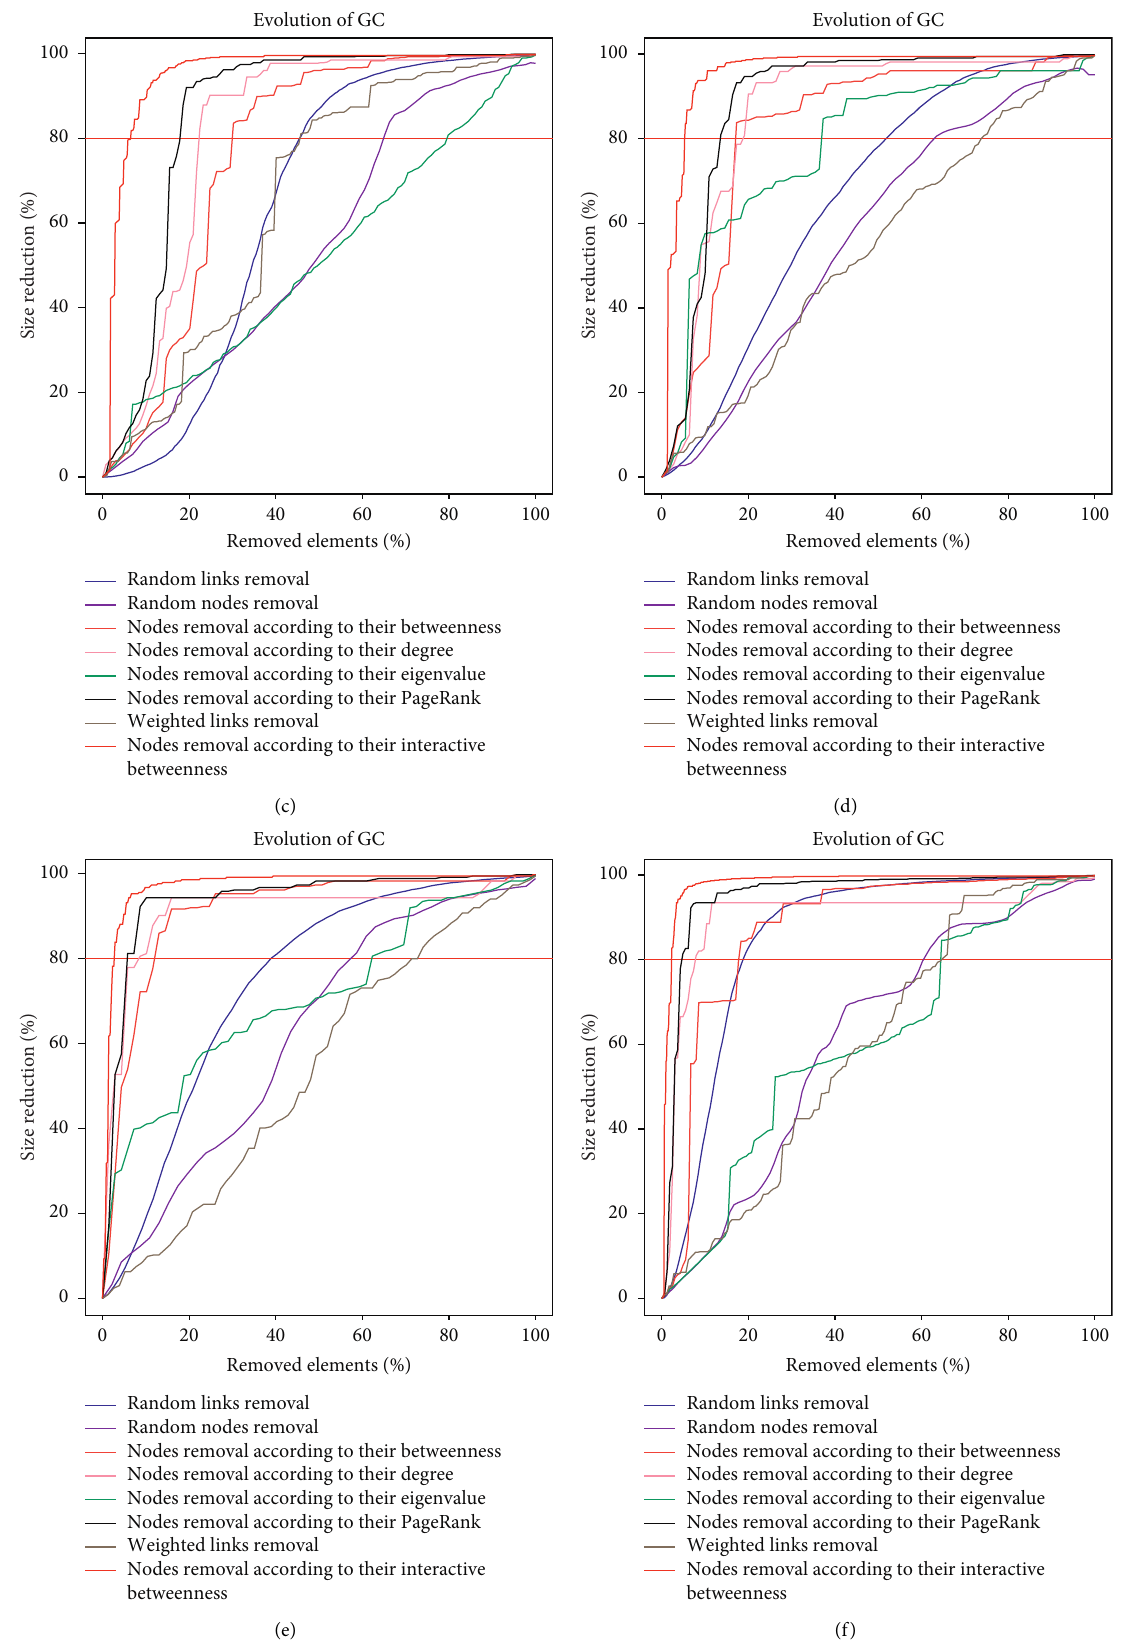
Figure 9: Evolution of the GC in AVL, CFL, RGTR, and TICE (a), STAR (b), TransAntofagasta (c), Linja-Karjala Oy (d), CIT Chambly- Richelieu-Carignan network (e), and Thunder Bay Transit